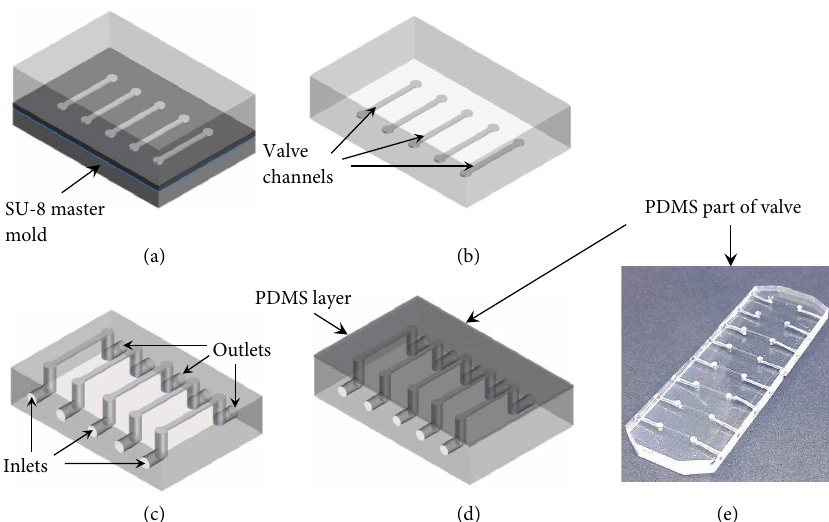
Figure 3: Fabrication of PDMS parts by rapid prototyping technique. (a) Pouring fresh PDMS on SU-8 mold; (b) Releasing PDMS channel from SU-8 mold after curing; (c) Making inlets and outlets of channel by PDMS tool kits; (d) Bonding a PDMS film on top of valve channel; (e) PDMS part of the valve.